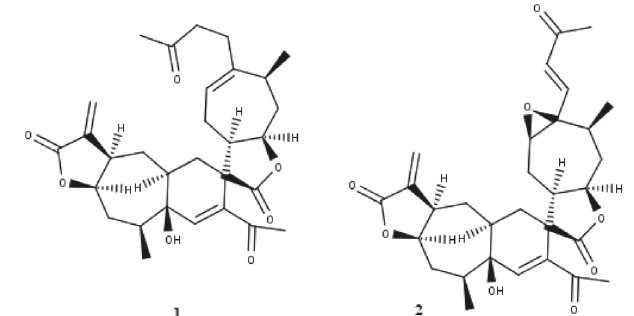
FIGURE 4 - Xanthanolide sesquiterpenes.